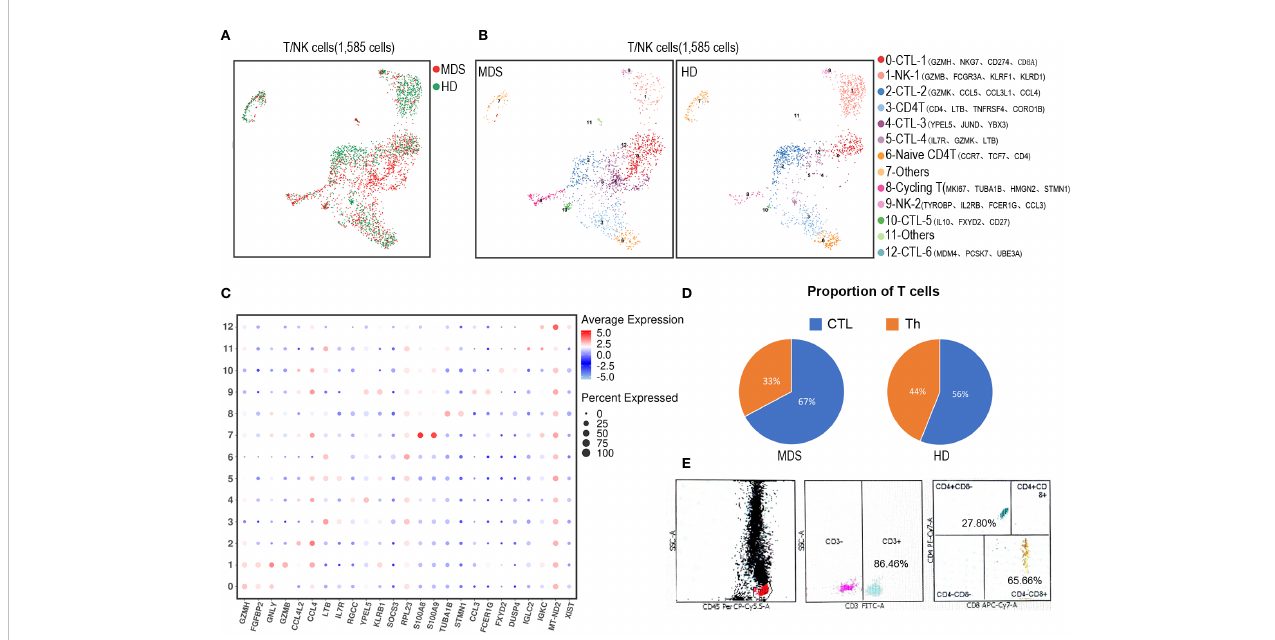
FIGURE 4 Dissection and clustering of T/NK subpopulations in the tMDS patient and HD. (A) t-SNE plot shows all identi fi ed T/NK subpopulations in tMDS and normal BM samples. The dot colored by source of donors. (B) UMAP plot of T/NK subpopulations from Figure 2B-represented CTL, Th and NK/NKT subsets. These T/NK cells can be divided into 13 subsets. (C) Dot plot of differently key cell-type marker genes. (D) Pie charts show relative ratio of cells annotated as CTL or Th cells in BM samples by scRNA-seq. (E) FCM analysis for T cells (CD3, CD4 and CD8) in the tMDS BM